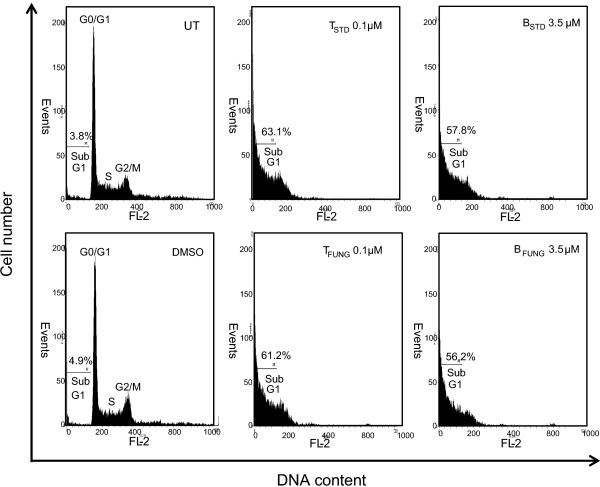
Taxol- and baccatin III-induced apoptosis in Jurkat cells assayed with PI staining followed by flow cytometry. Cells (0.25 × 106) were treated with indicated concentrations of taxol or baccatin III for 48 h, and analyzed by PI staining followed by flow cytometry to determine the hypodiploid DNA (fragmented DNA) proportions. 1 × 105 cells were analyzed. The percentage of hypodiploid cells (sub G1 peak) was calculated on the basis of the respective histograms. UT, Untreated cells; DMSO, Dimethylsulfoxide; TSTD, standard taxol; TFUNG, fungal taxol; BSTD, standard baccatin III; BFUNG, fungal baccatin III.